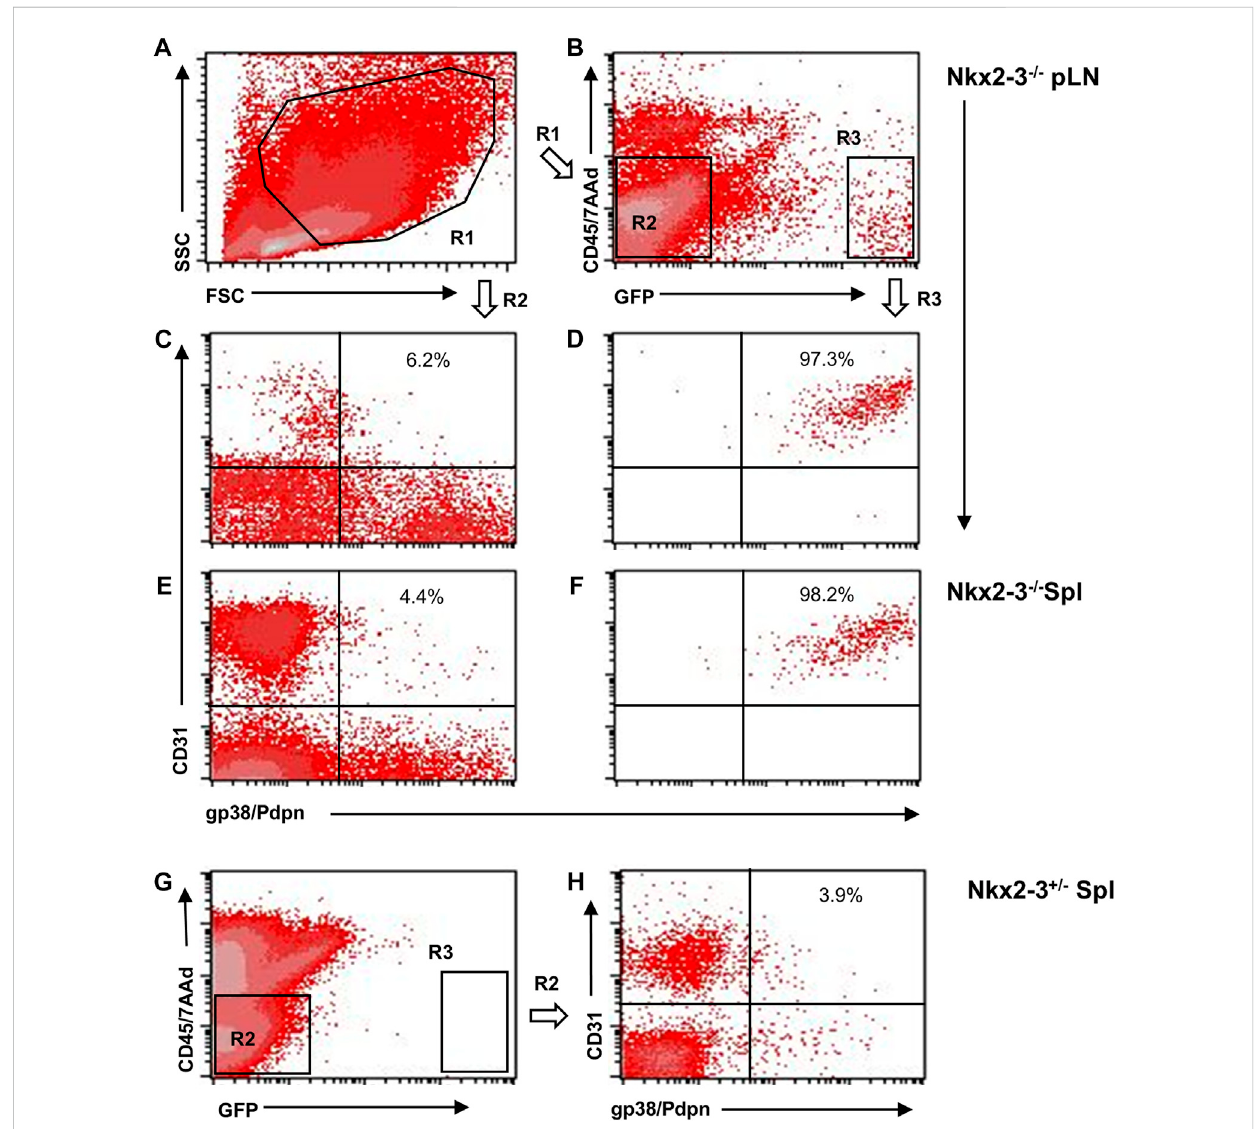
Flow cytometric characterization of Prox1:eGFP + cells in mice lacking Nkx2-3. Peripheral lymph nodes (pLN) were gated to include large stromal cells[ (A) ,R1]andeithereGFP − [ (B) ,R2/left]oreGFP + [ (B) ,R3/right]cells,thenresolvedaccordingtotheirgp38(podoplanin)/CD31features.Representative images demonstrate that the Prox1:eGFP + (R3) cells in both pLN (D) and spleen (Spl, (F) from Nkx2-3 − / − mice display gp38/CD31 double positive LEC phenotype (numbers indicating their frequency), whereas eGFP:Prox1 - cells from Nkx2-3 − / − pLN (C) and spleen (E) constitute non-LEC stromal subsets. In Nkx2-3 +/- spleens no GFP + signal is present (G) . (H) , gp38(podoplanin)/CD31 staining of GFP − (R2) cells in Nkx2-3 +/- spleens. Representative dot plots from n = 4, experiment repeated